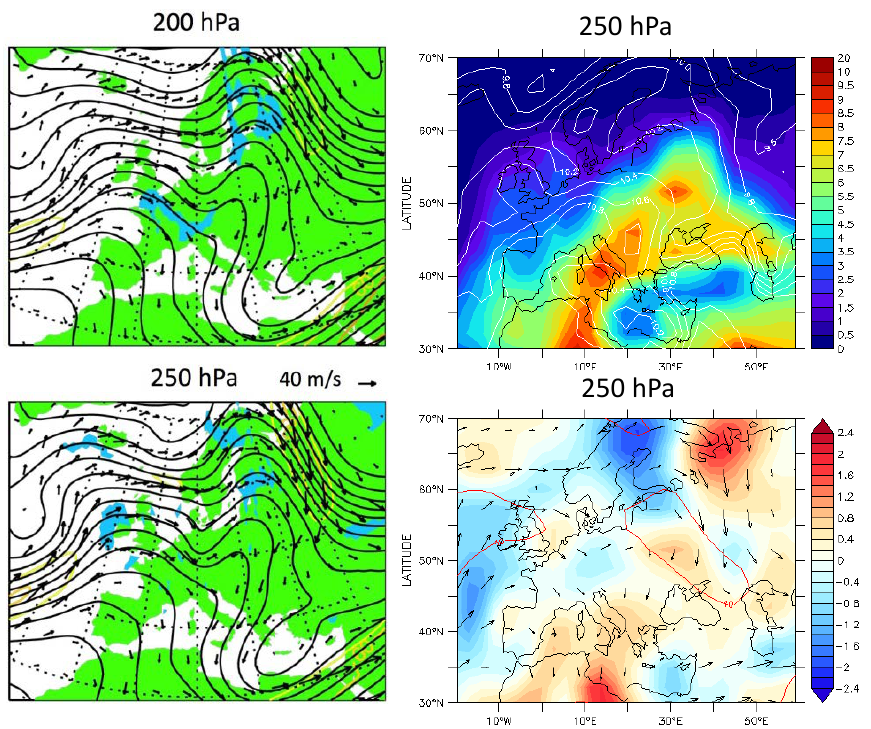
Figure 4. Synoptical situation on 18 December 2015: geopotential height, wind and contrail supersaturation ( blue ) in 200 hPa ( top left ) and 250 hPa ( bottom left ), ozone production efficiency ( top right ), and vertical motion [m/s] ( bottom right ) and location of jet (redline representing 40 m/s